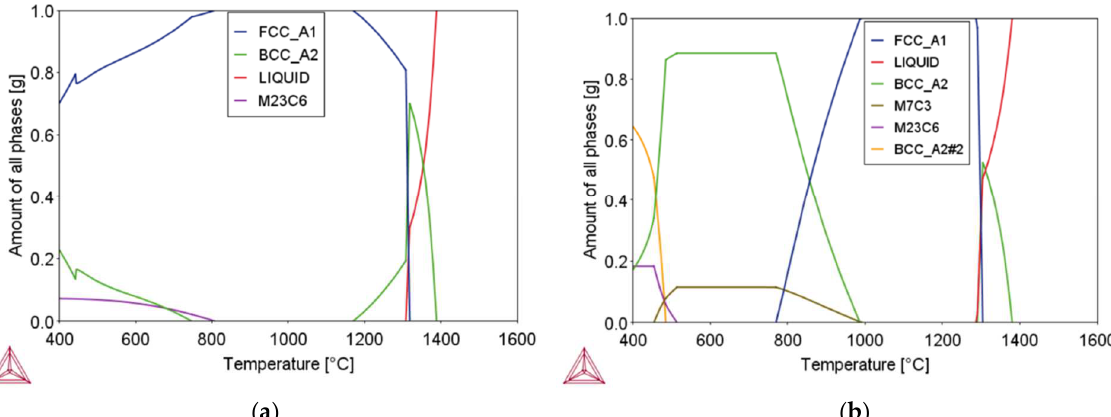
Figure 3. Phase prediction from Thermo-Calc for ( a ) Fe-30.9Mn-4.9Al-4.5Cr-0.4C; ( b ) Fe-21.3Mn-